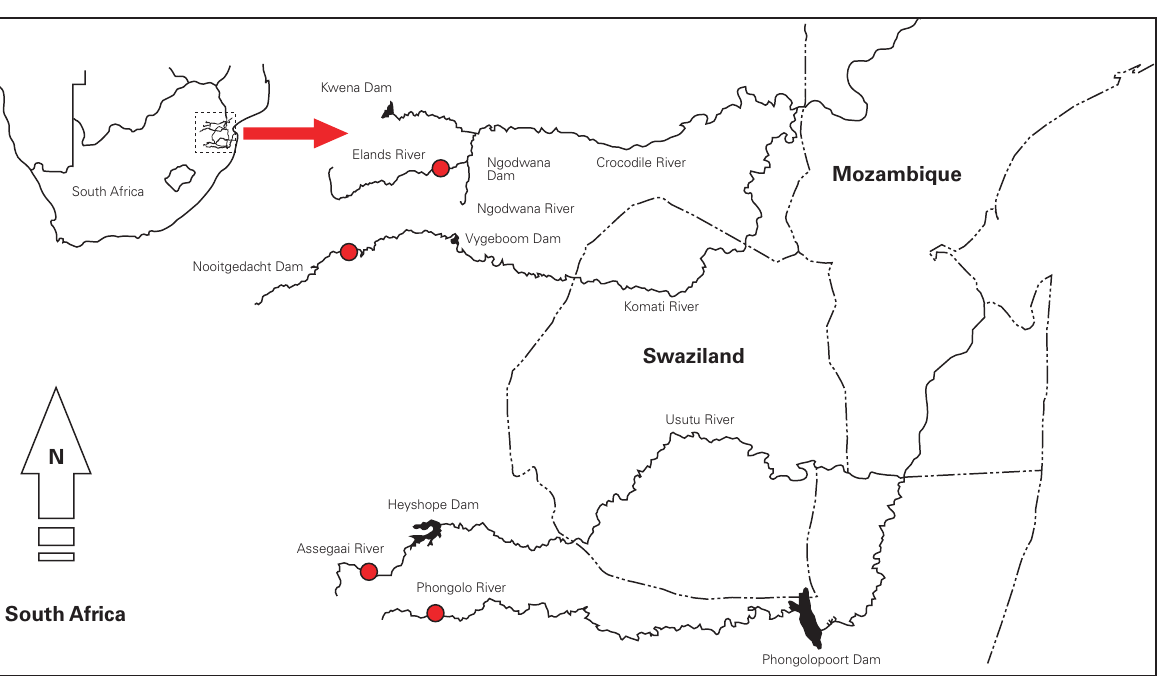
FIG. 1 Map indicating the geographic distribution of Labeobarbus polylepis sampled in four rivers (Elands, Phongolo, Assegaai and Komati rivers) in Mpumalanga, South Africa. Dots indicate the position of the sampling